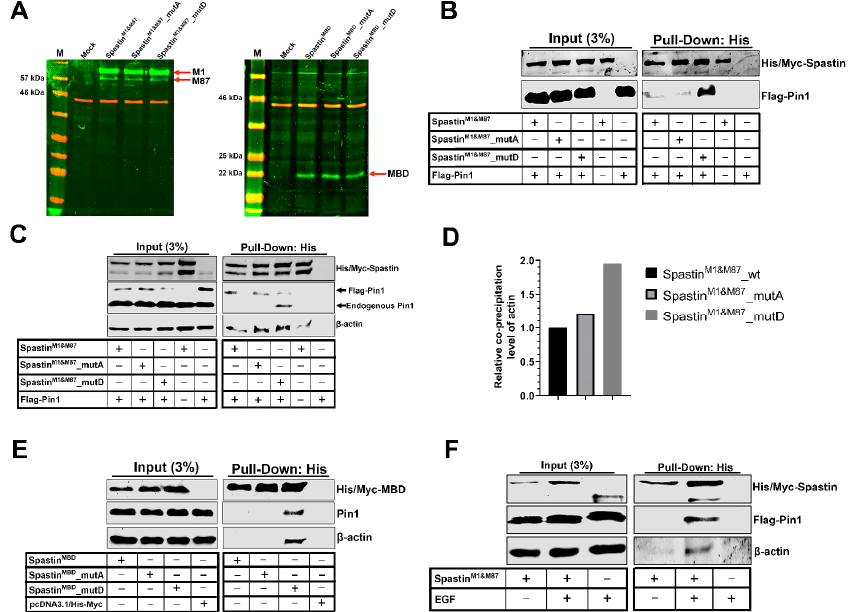
Figure 5. Pin1 interacts with Spastin through Pin1 recognition motifs in its microtubule ‐ binding domain (MBD). ( A ) The expression levels of the proteins expressed from either the full ‐ length or MBD ‐ only Spastin constructs were analyzed through Western blot (WB). Green bands indicate the expressions of either the full ‐ length Spastin (left panel) or MBD ‐ only proteins (right panel) in the wild ‐ type or mutant forms. ꞵ ‐ Actin observed as red bands was used as the loading control. ( B , C ) The pull ‐ down assay was used to examine the interaction of the full ‐ length Spastin with Pin1 ( B ) and actin ( C ), respectively. Spastin M1&M87 proteins were precipitated from cell lysates (HEK293T in B , and T98G in C ) overexpressing the wild ‐ type or mutant Spastin M1&M87 proteins dually with Pin1 ‐ Flag. Then, co ‐ precipitation of Pin1 or actin with each wild ‐ type and mutant Spastin proteins was investigated by WB. ( D ) The bar graphs represent the amount of co ‐ precipitated actin with the full ‐ length wild ‐ type or mutant Spastin M1&M87 protein. The quantification was performed by dividing the amount of precipitated actin to the amount of precipitated wild ‐ type or mutant Spastin proteins. ( E ) The interaction between Spastin’s MBD region with Pin1 was investigated by pull ‐ down assay. Each Spastin MBD protein was precipitated from HEK293T cells overexpressing either the wild ‐ type or mutant Spastin MBD constructs singly. Then, co ‐ precipitation of the endogenous Pin1 or actin with each wild ‐ type or mutant Spastin protein was investigated by WB. ( F ) To analyze the impact of EGF treatment in the interaction of Spastin with Pin1, pull ‐ down experiment was performed. Exogenous wild ‐ type Spastin protein was precipitated from lysates isolated from Spastin M1&M87 ‐ overexpressed T98G cells either treated with EGF or not. The co ‐ precipitation of Flag ‐ Pin1 or actin with Spastin was investigated by WB.